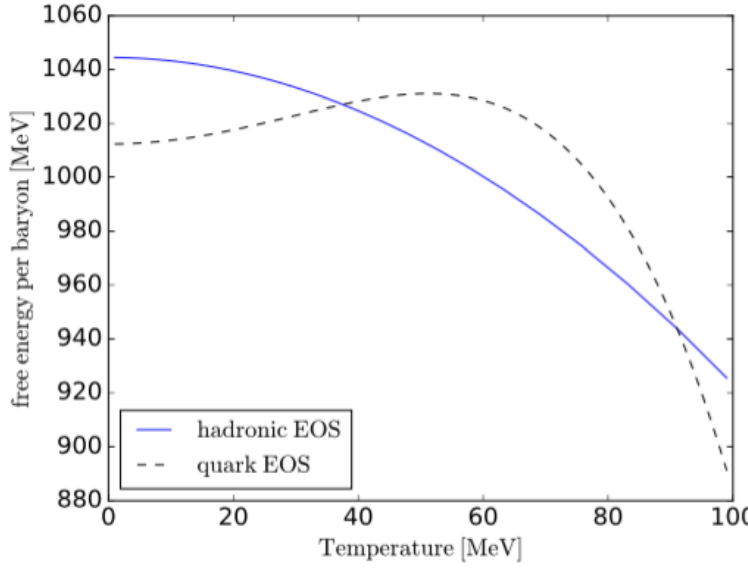
Figure 1. Free energy per baryon versus temperature for the hadronic EOS [41] and that of (u,d,s) (the MIT bag EOS with strong coupling constant corrections) used in this work. The free energy of (u,d,s) becomes higher around T ∼ 40 MeV, which blocks the conversion from hadronic to quark matter. Reprinted from Ref.